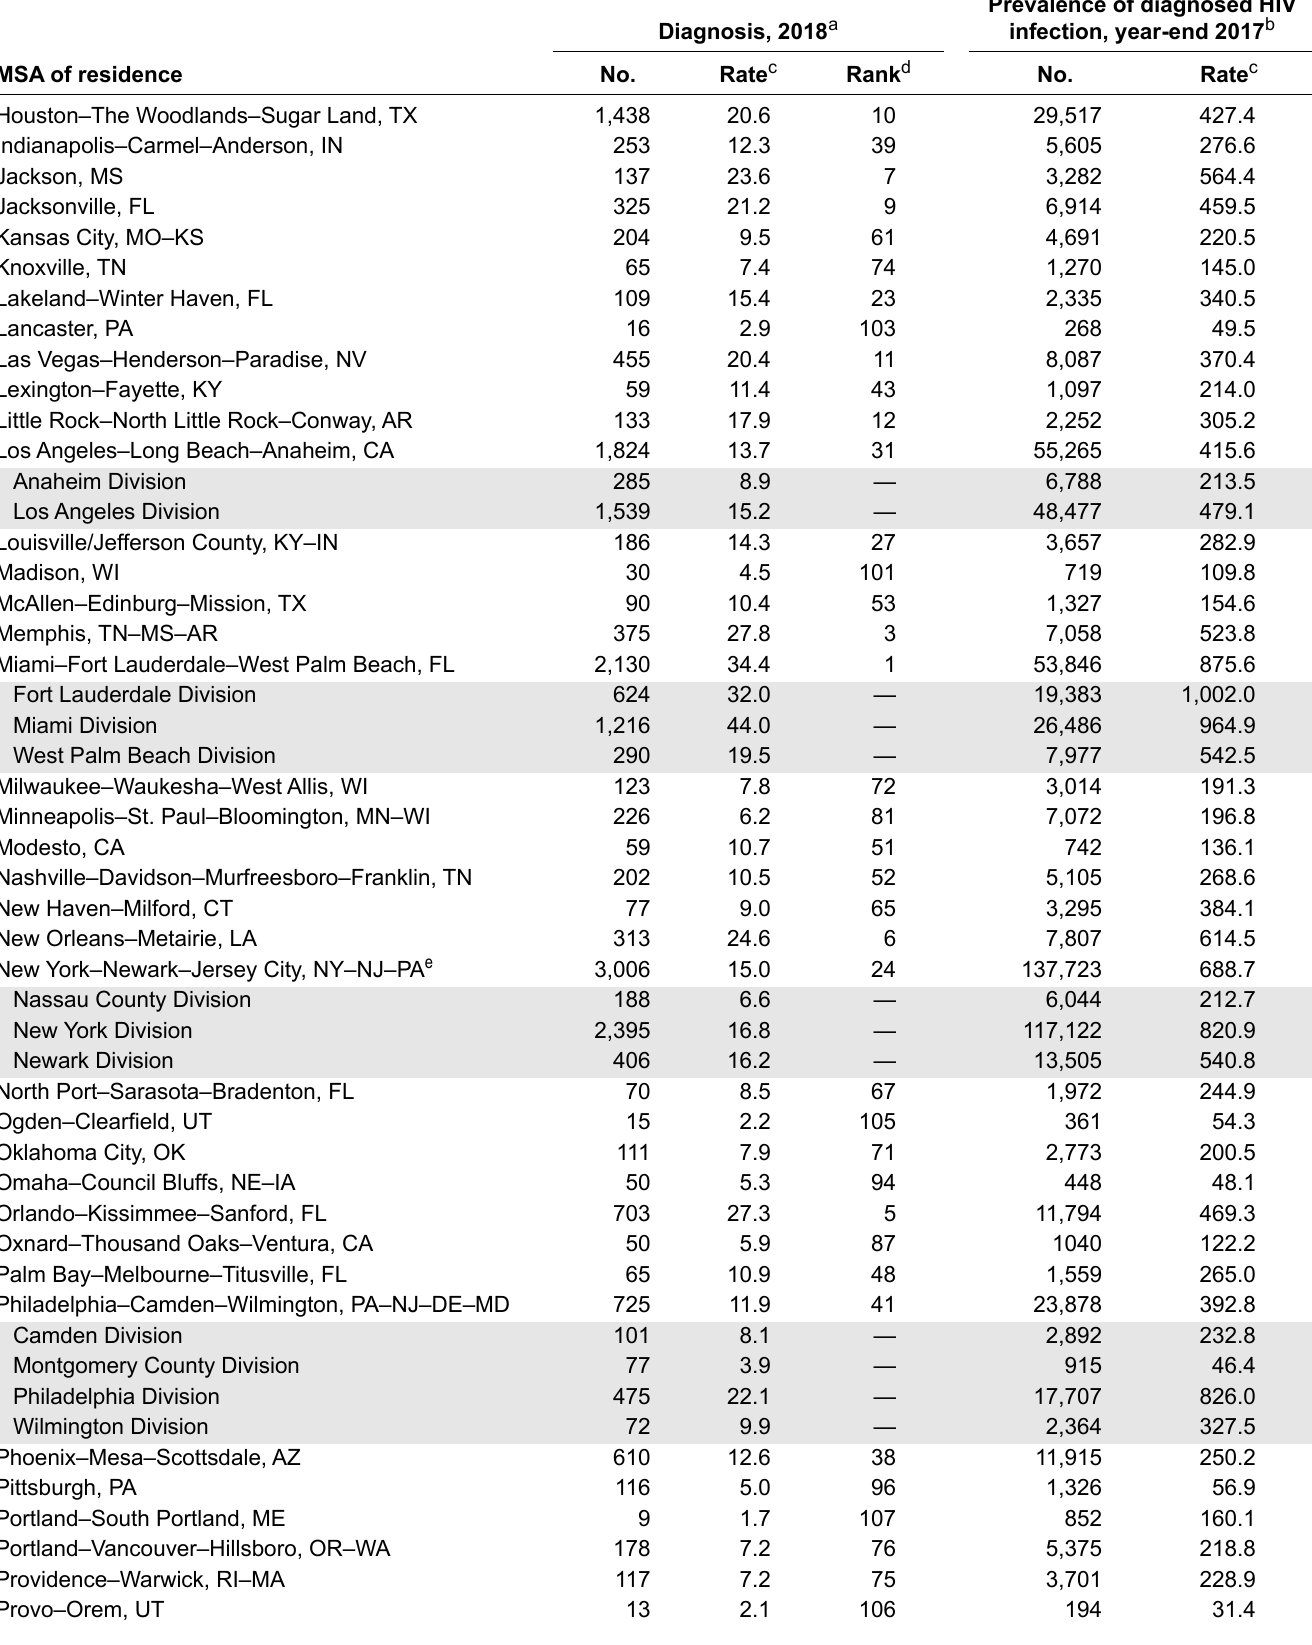
Table 30. Diagnoses of HIV infection, 2018, and persons living with diagnosed HIV infection (prevalence), year- end 2017, by metropolitan statistical area of residence—United States and Puerto Rico